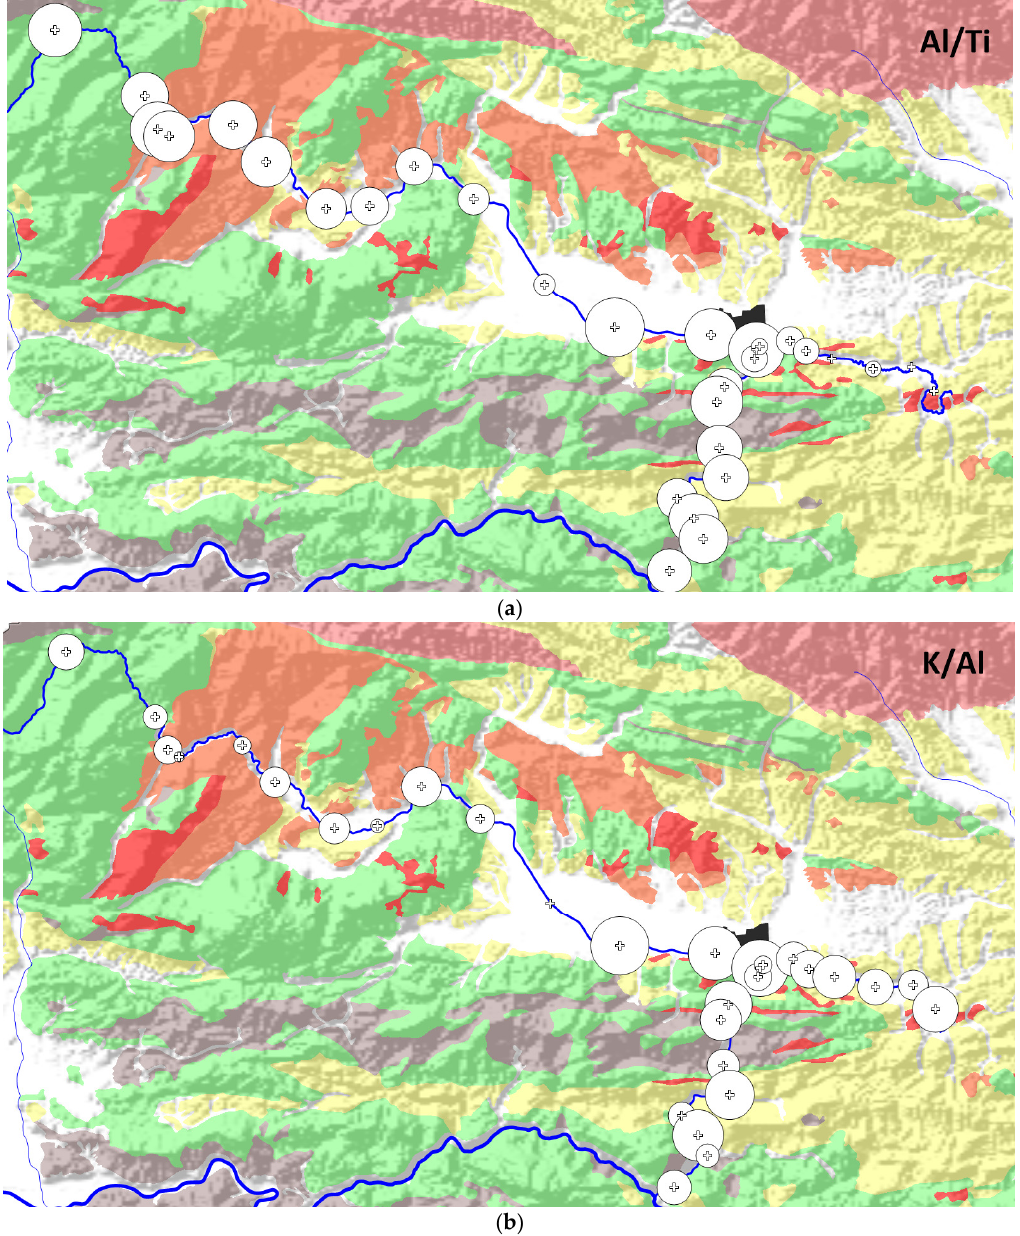
Figure 3. The distribution of the Al/Ti ( a ) and K/Al ( b ) ratios in stream sediments of the Savinja and Voglajna rivers in the <0.063 mm fraction. The size of the symbol is linearly proportional to the ratio. Color coding is identical as on Figure 1.